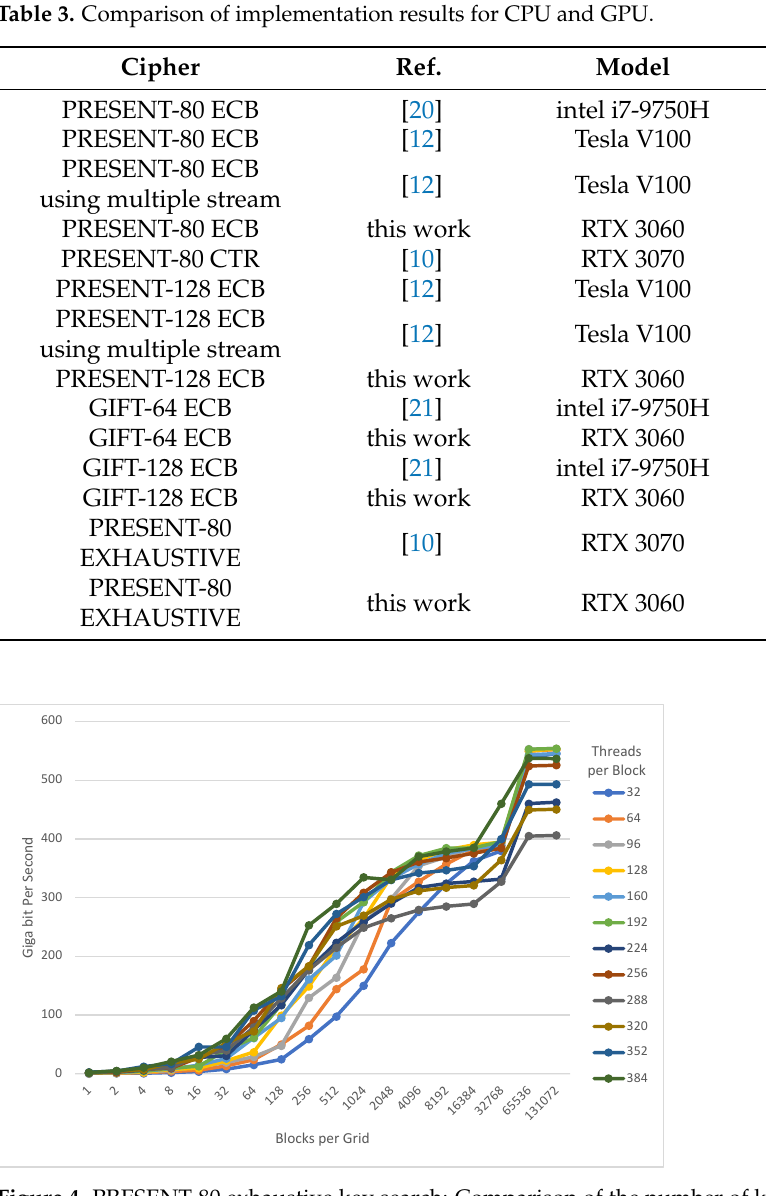
Figure 4. PRESENT-80 exhaustive key search: Comparison of the number of key-search per